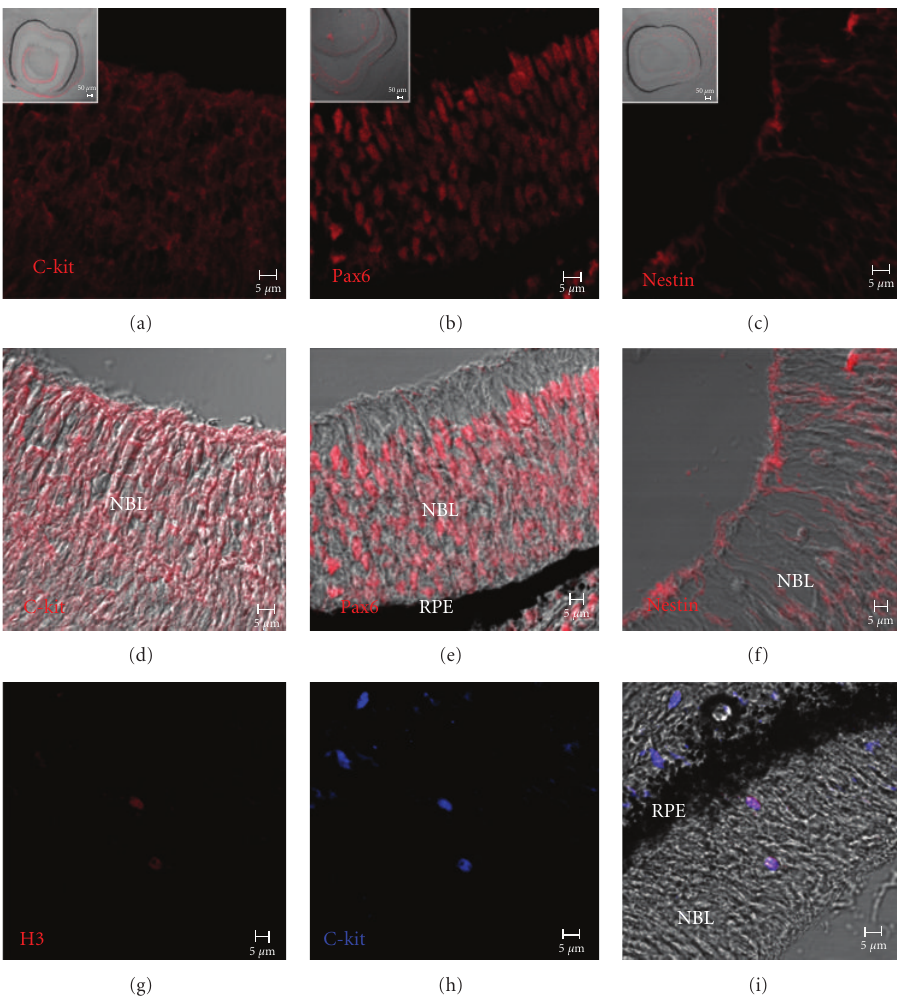
Figure 2: Immunofluorescent staining of C-kit (a and d), Pax6 ((b) and (e)) and Nestin ((c) and (f)) in the retina from dog embryos. The expression was observed in the NBL, examined in combination with Nomarski optics. Inserts present a panoramic view of the pattern of expression for the C-kit, Pax6 and Nestin. (g) Confocal image showing the proliferation of cells stained with H3. (h) The same figure presented in (g) but here the C-kit positive cells are evident. (i) Merged image showing cells expressing both C-kit (blue) and H3 (red) proteins in combination with Nomarski